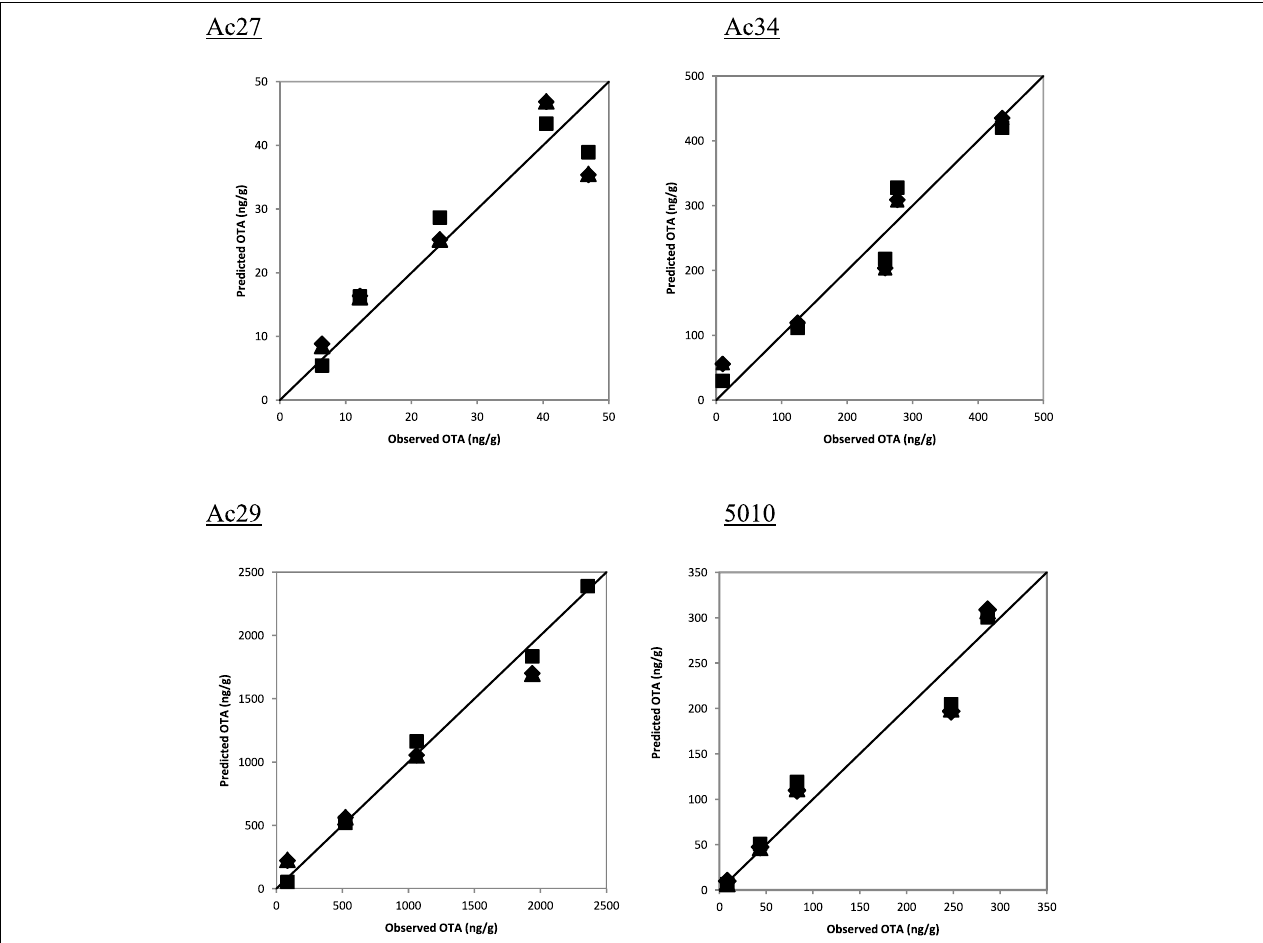
FIGURE 5 | Indicative diagrams of observed vs. predicted values of OTA through diameter ( (cid:4) ), colony area ( N ), biomass ( (cid:7) ).